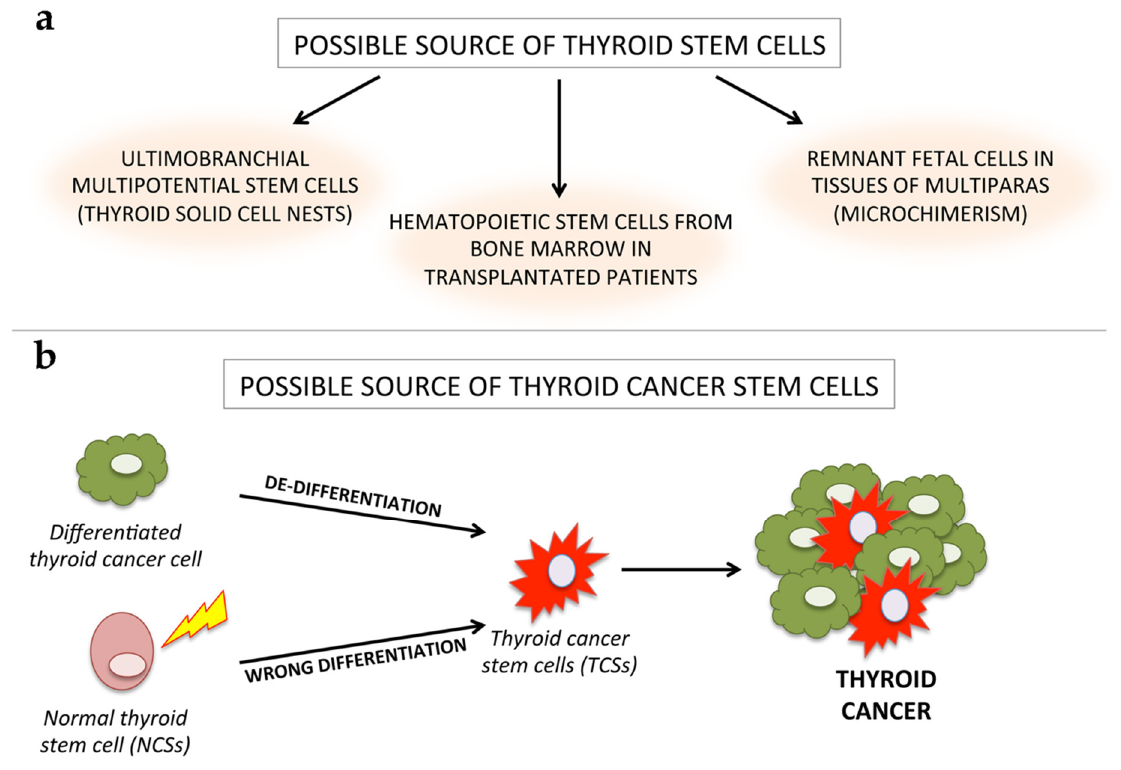
Figure 2. The possible origin of thyroid stem cells (SCs). ( a ) Di ff erent hypotheses about the origin of thyroid SCs: (1) from ultimobranchial body cell nests; (2) from stem cells migrating from di ff erent tissues (e.g., bone marrow) and (3) from remnant fetal cells present in tissue of multiparas. ( b ) TCSs may originate either from transformation of normal thyroid stem cells or through de-di ff erentiation of thyroid cancer cells which assume CSC characteristics. According to this model, CSCs are a key component of tumor